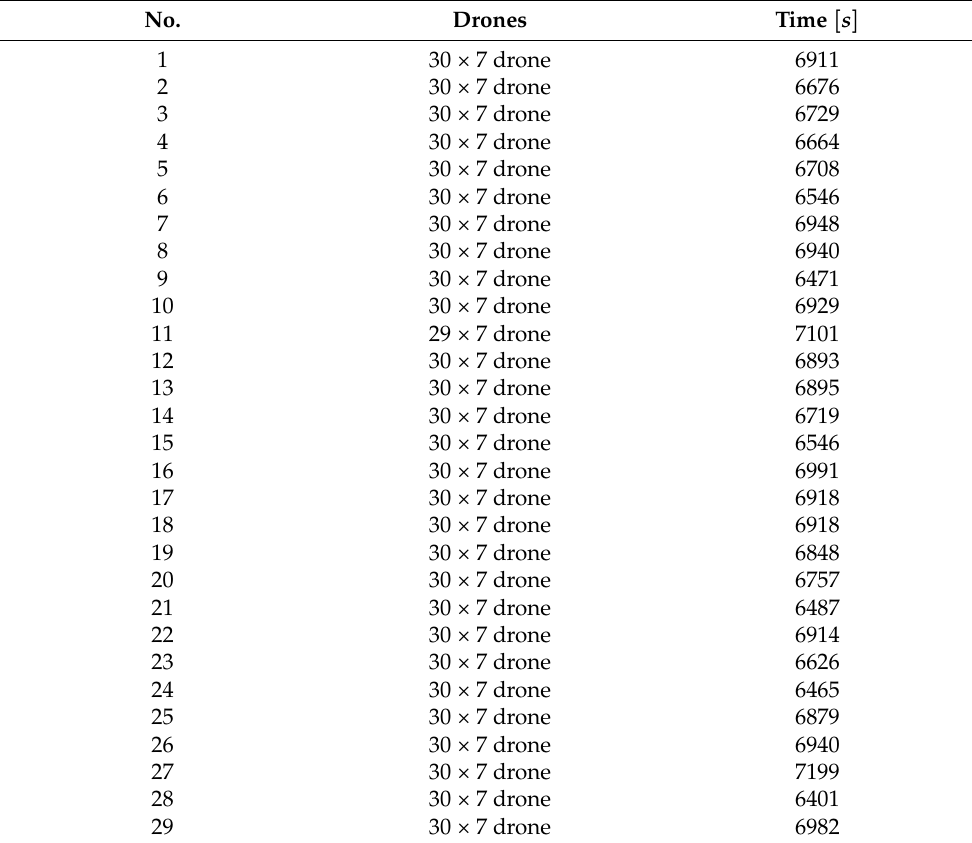
Table 3. Results of simulations with four UAVs.